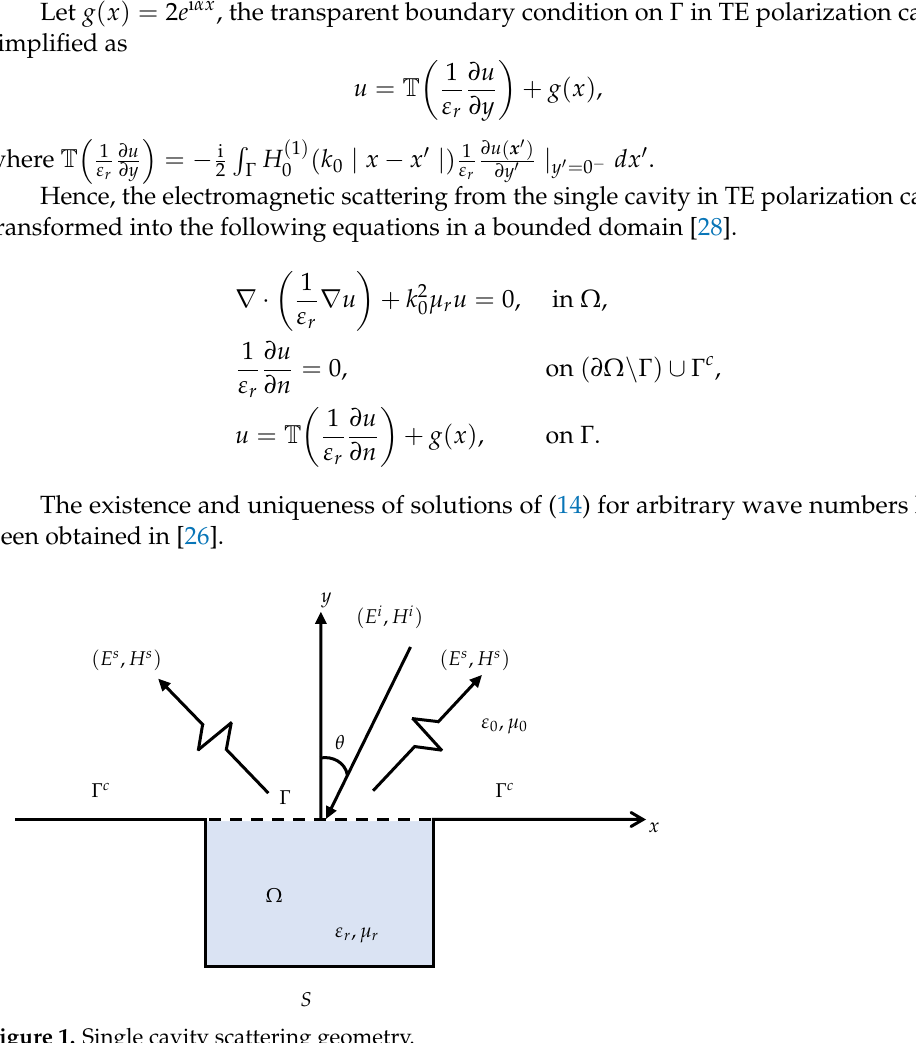
Figure 1. Single cavity scattering